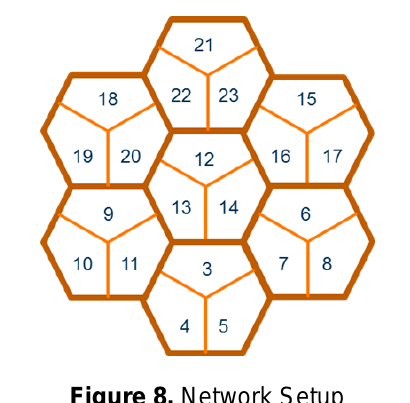
Figure 8. Network Setup Table 1. LTE simulator – system parameters and